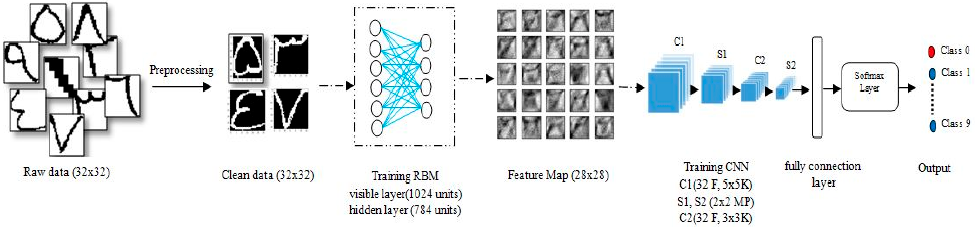
Figure 5. Final structure of the proposed RBM–CNN model (C: convolutional layer, S: sub sampling layer, FC: fully connected layer, F: filters, K: kernels, MP: MaxPooling).